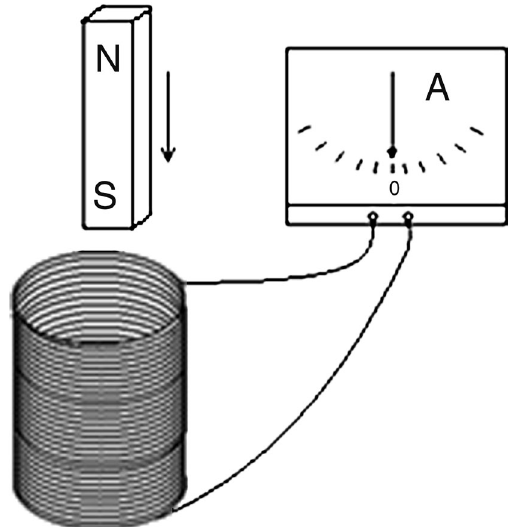
FIG. 4. Experiment 4: demonstrating electromagnetic induc- tion. The magnet was inserted in the coil, left for some time at rest inside it, and then again removed from the coil. Students were allowed to perform the experiment on their own to try different orientations or speeds of the magnet entering the coil. An additional experiment was shown using another coil with less windings than the first one.